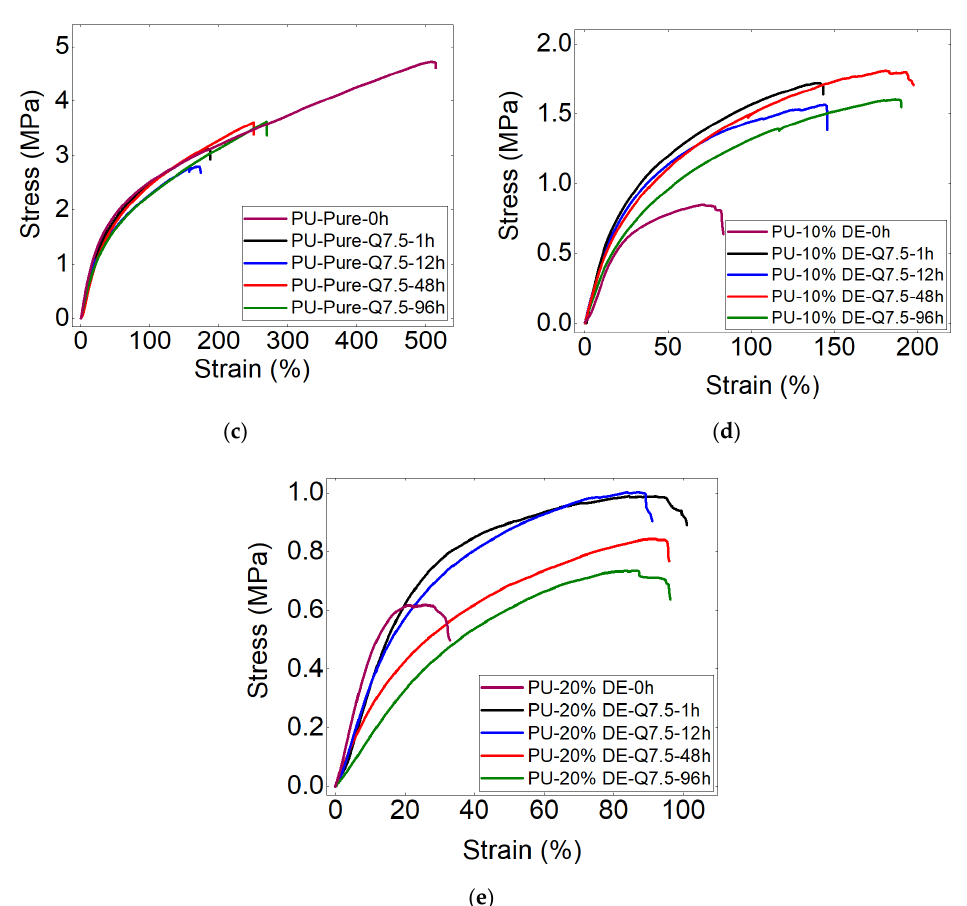
Figure 7. Stress–strain curves of ( a , c ) pure PU, ( b , d ) PU-10%DE and ( e ) PU-20%DE samples at different flow rates (PU-10%DE-Q7.5: polyurethane-10% diclofenac epolamine—flow rate of 7.5 mL/s).